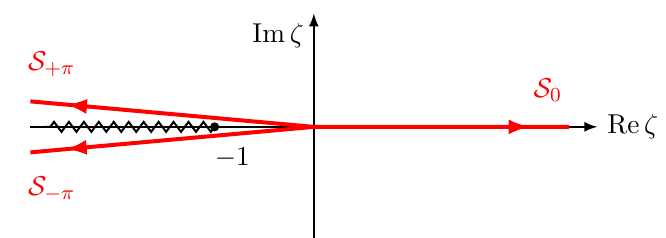
Figure 1 . The contours where the directional Laplace transformations are taken. For τ > 0 , S 0 gives the full result of the Borel summation, free from nonperturbative ambiguities. The Stokes line on the negative ζ axis induces two different lateral Laplace transformations, S + π and S − π , that are relevant for the τ < 0